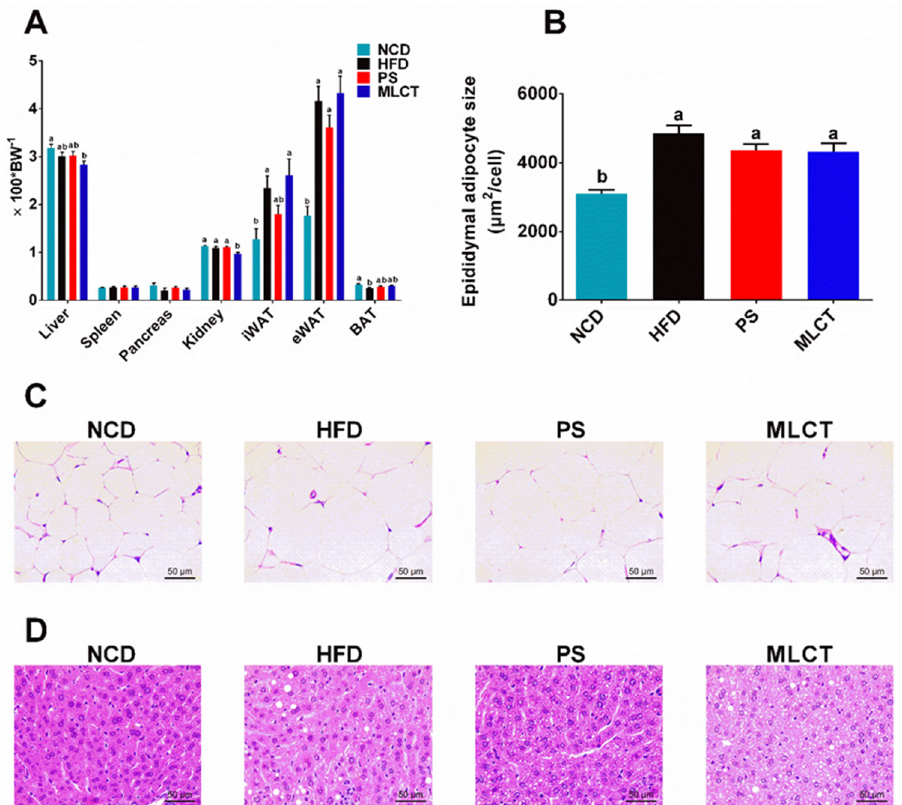
Figure 2. Organ indexes and morphological changes. ( A ) The weight percentage of organs. ( B ) Adipocyte size of eWAT ( n = 6). ( C ) H&E staining of eWAT. ( D ) H&E staining of liver tissues. In ( B ), means with the different lowercased letters differ significantly ( p < 0.05) according to one-way ANOVA analysis followed by Tukey’s tests.